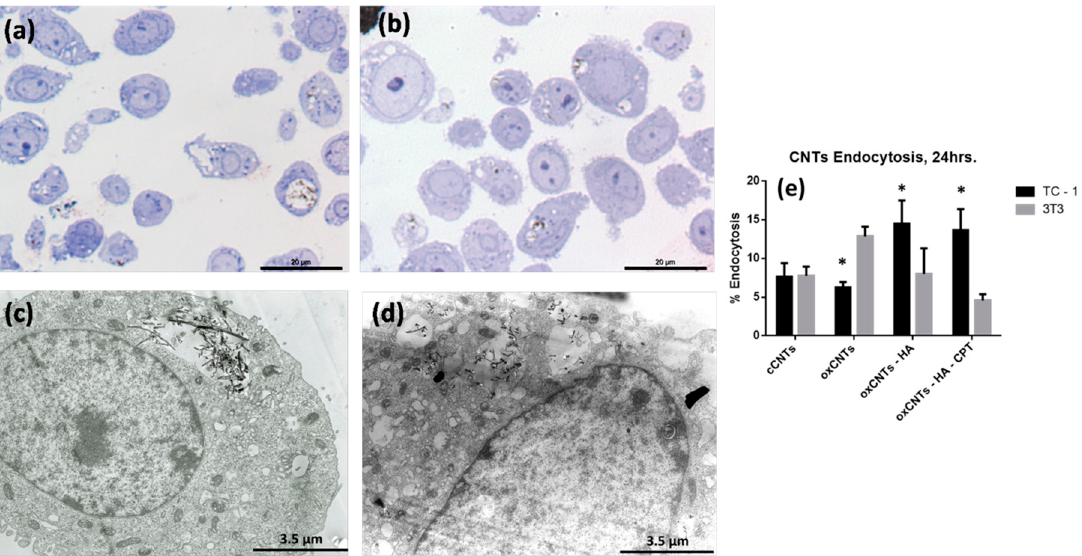
Figure 2. Nanovectors cell uptake. ( a ) Control TC–1 Cells (cCNTs). ( b ) Treated TC–1 Cells